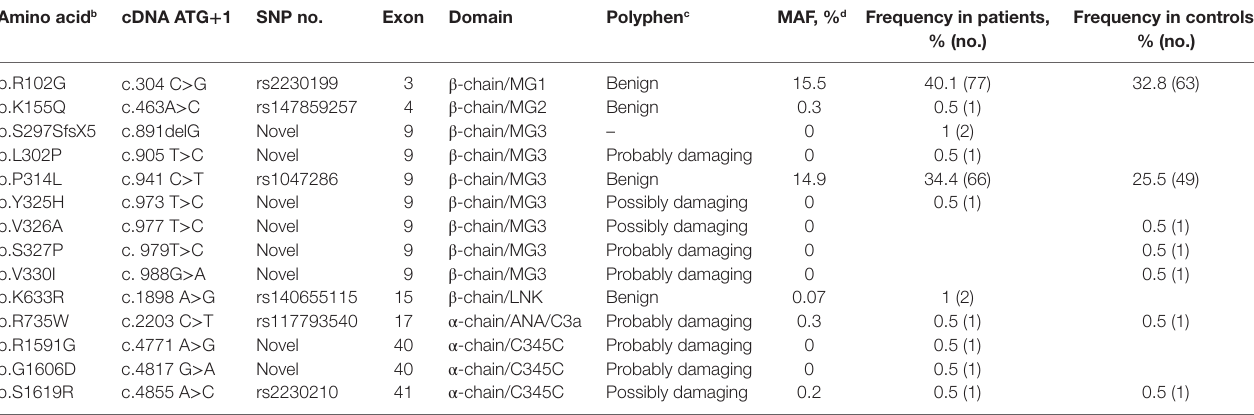
TaBle 3 | Mutations and polymorphisms found in C3 . a